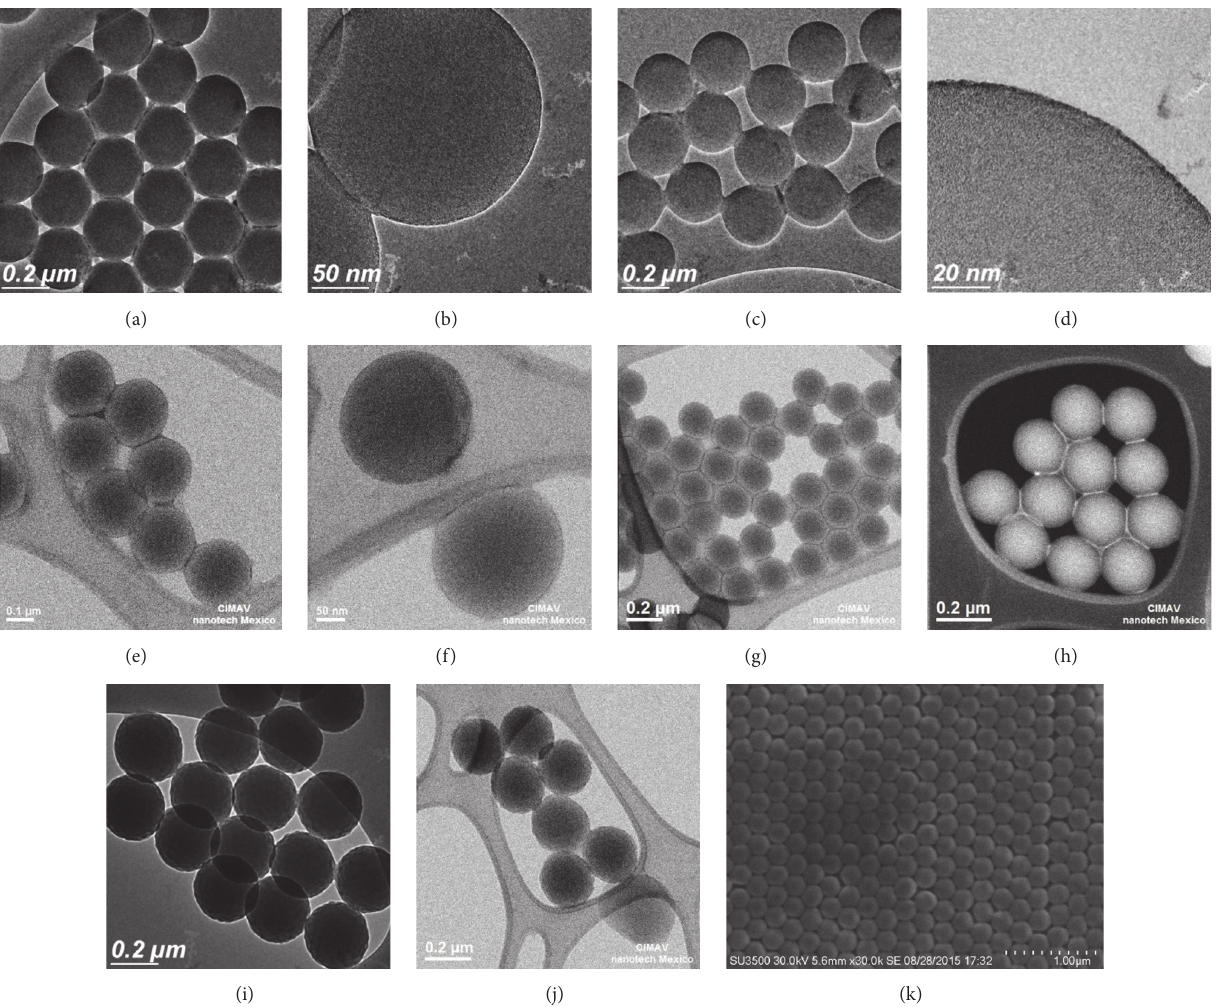
Figure 3: Bright field TEM micrograph of synthetized microspheres: Rx-24, 18% of IOA (a, b); Rx-30 with 22% of EHA (c, d); Rx-37 with 18% of HA (e, f); Rx-62 with 16% of BA (g, h); Rx-27 and Rx-53 with 13 and 18% of IBA (i, j), respectively (images from (e) to (j) were taken by STEM mode). SEM micrograph of Rx-29 with 21% of EHA